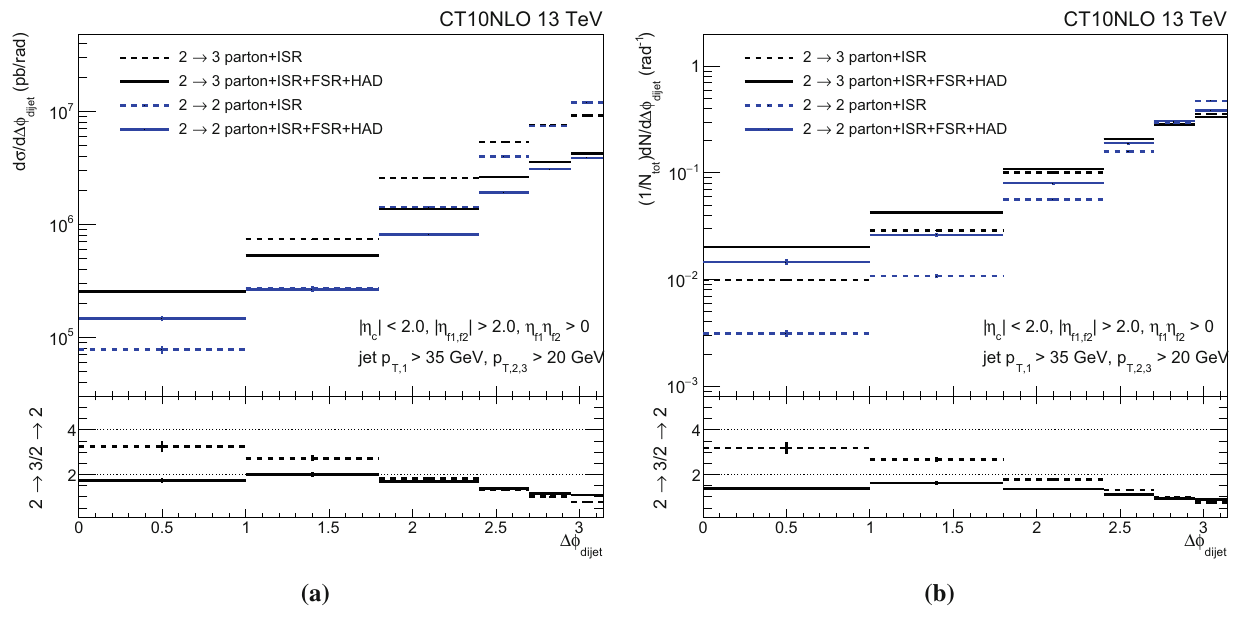
Fig. 6 On-shell predictions with the CT10NLO PDF with initial state radiation included (dashed lines), and at hadron level (solid lines) for both2 → 2(bluelines)and2 → 3(blacklines)matrixelementcalcula-